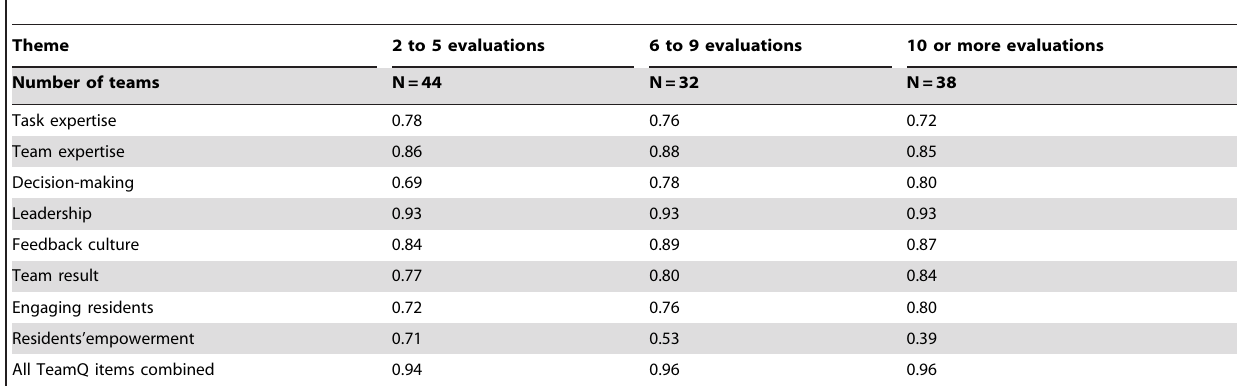
Table 7. Observed reliability levels ( a ) for teams with a different number of completed TeamQ evaluations.